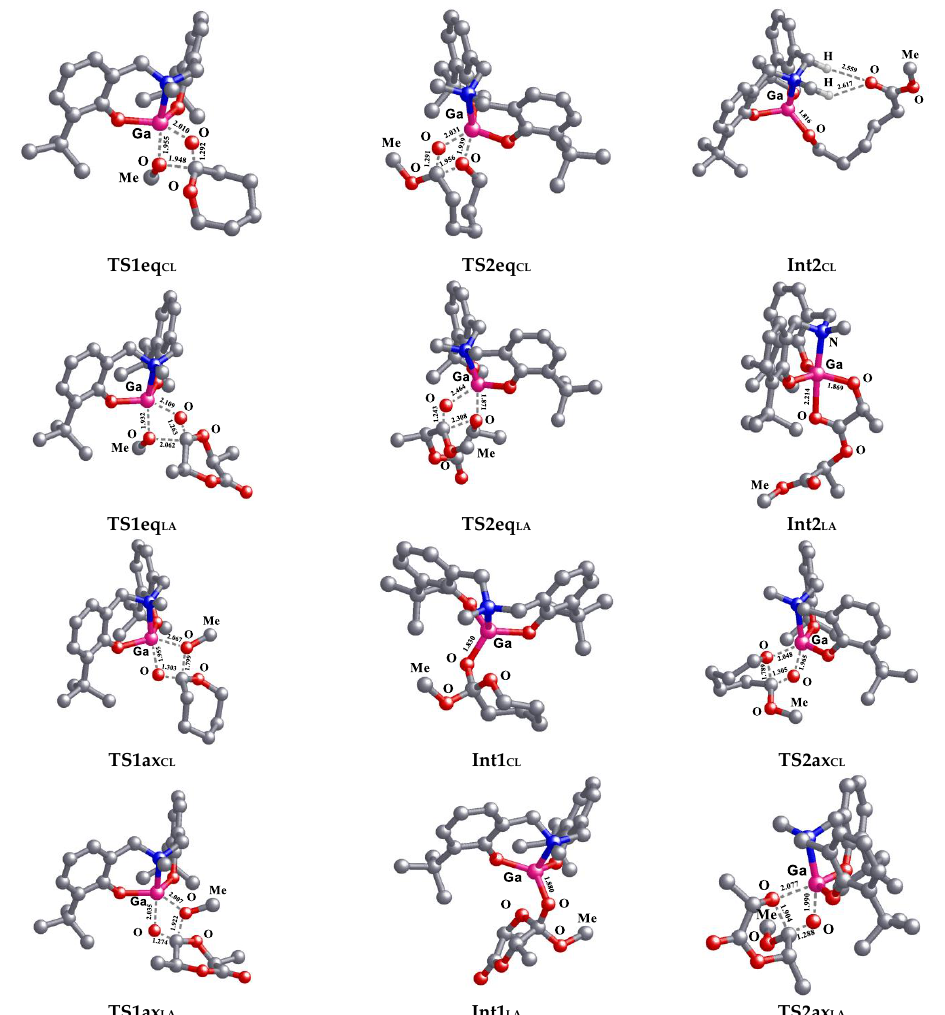
Figure 2. The representative structures of transition states and intermediates of initiation step. Hydrogen atoms are omitted for clarity where they do not participate in the formation of hydrogen bonds.